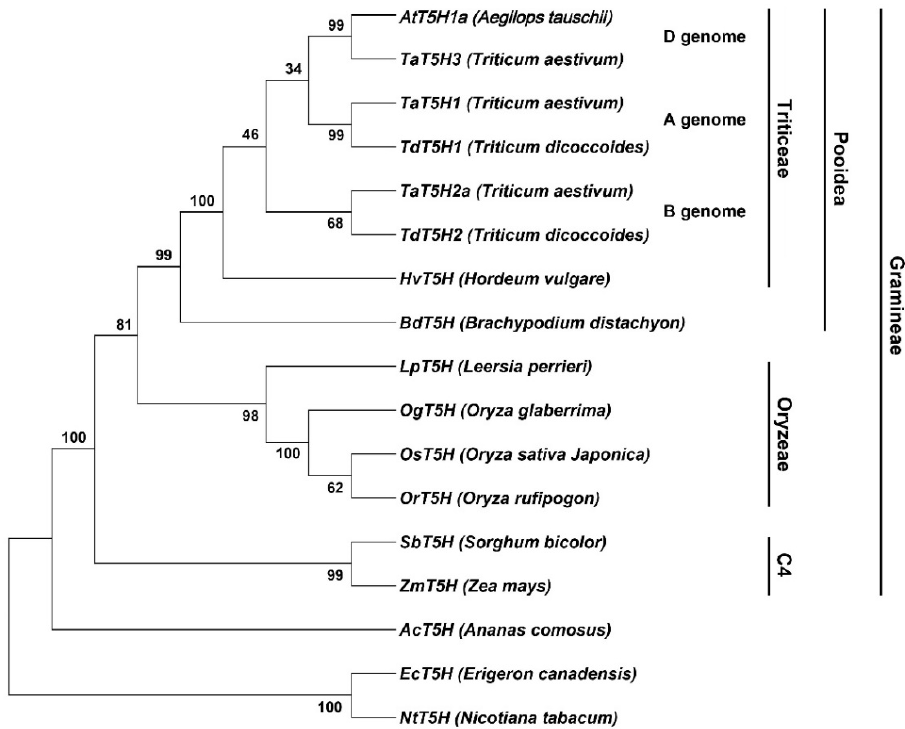
Figure 2. A phylogenetic tree of tryptamine 5-hydroxylase (T5H) homologs in cereal crops and other plant species. The picture was constructed by the Neighbor-Joining method using the MEGA11 software. Bread wheat is an allohexaploid with the AABBDD genome, and, not surprisingly, bread wheat has three sets of melatonin biosynthesis genes. The phylogenetic profiles agree very well with the evolutionary relationships of these organisms. Table 1. Number of genes for the melatonin biosynthesis pathway in four major cereal crops. Rice Barley Oryza sativa